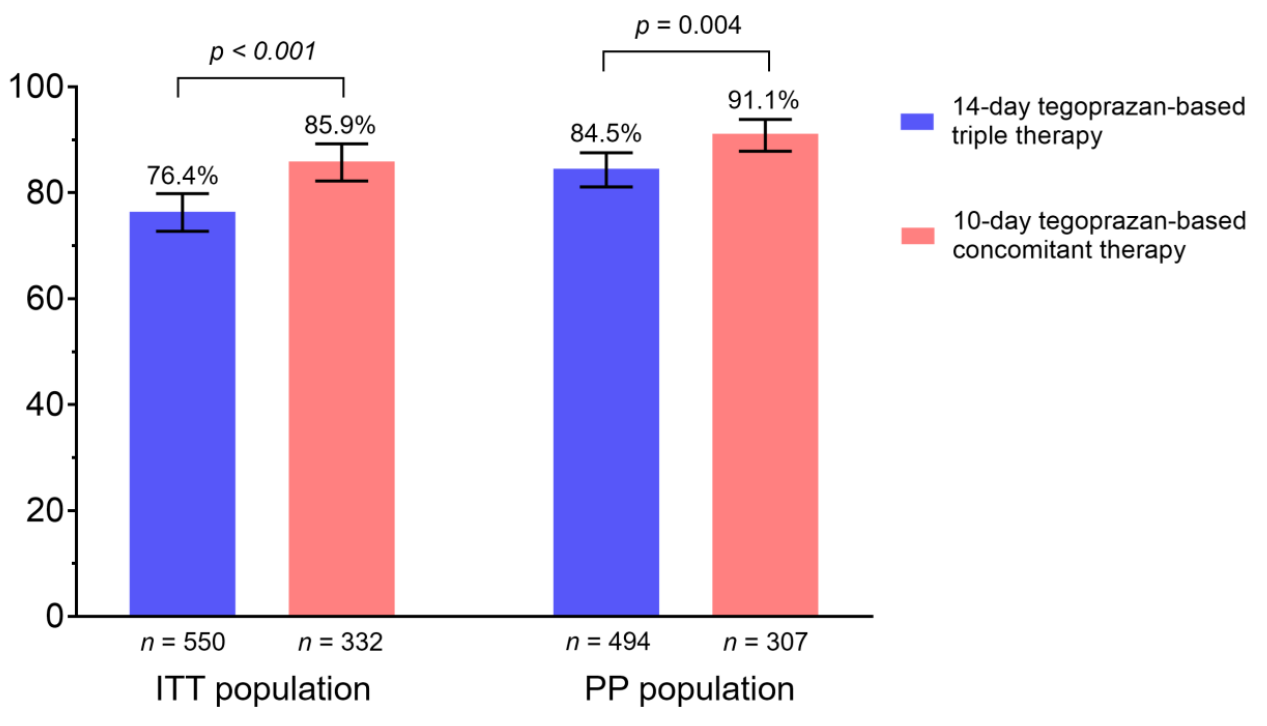
Figure 2. Success rate of the first-line Helicobacter pylori eradication therapy. ITT, intention-to-treat; PP, per-protocol.